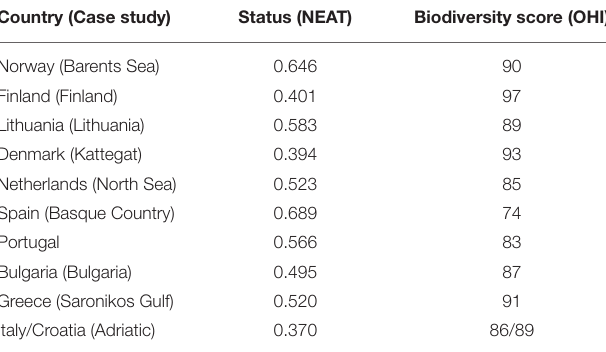
TABLE 5 | Comparison of the biodiversity assessments obtained using the Ocean Health Index (OHI; data from Selig et al., 2013) and the Nested Environmental status Assessment Tool (NEAT) (this study) in the countries for which NEAT has case studies. Country (Case